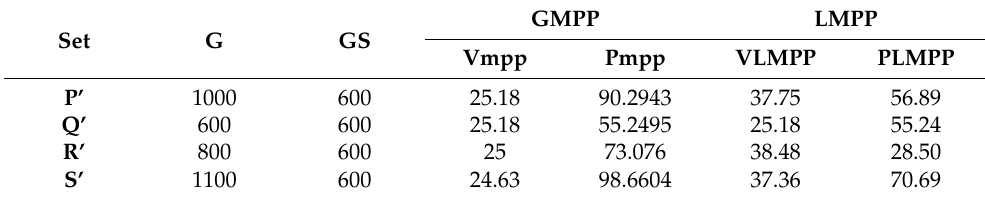
Figure 3. ( a ) Partial shading affects 25% of the panel area and ( b ) P-V curves under different partial shading conditions. Table 3. MPP values extracted under different uniform